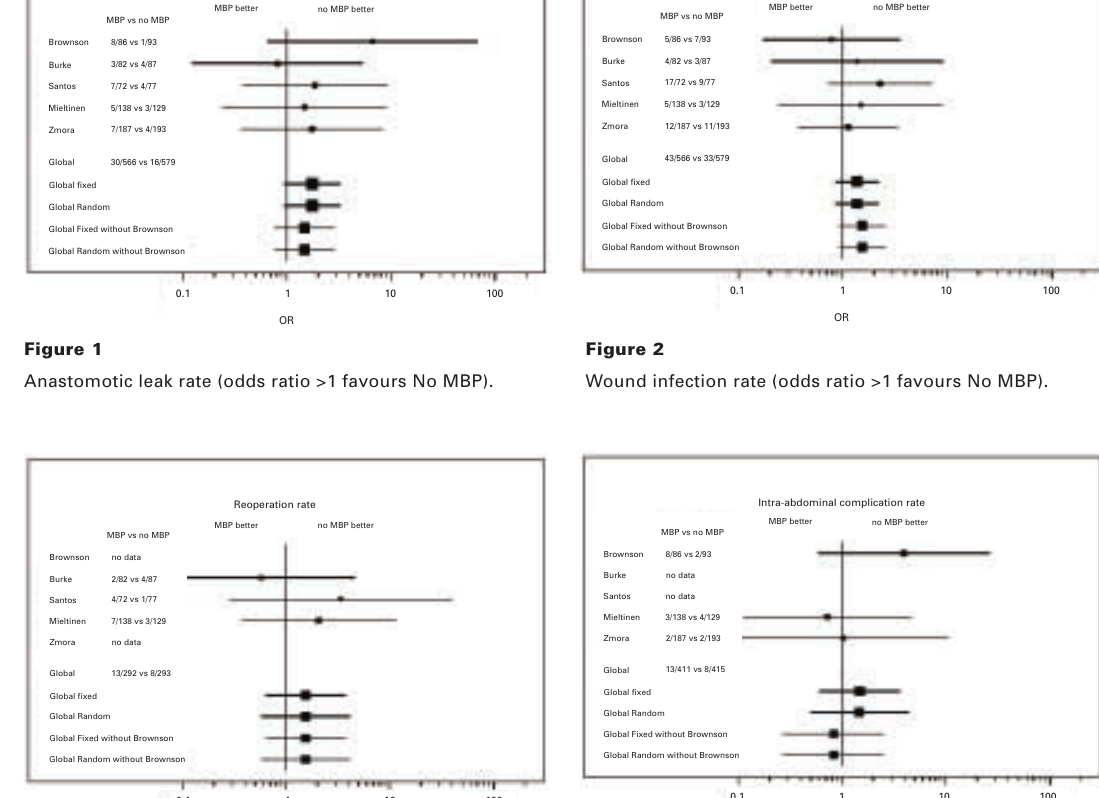
Figure 4 Intra-abdominal complication rate (odds ratio >1 favours No